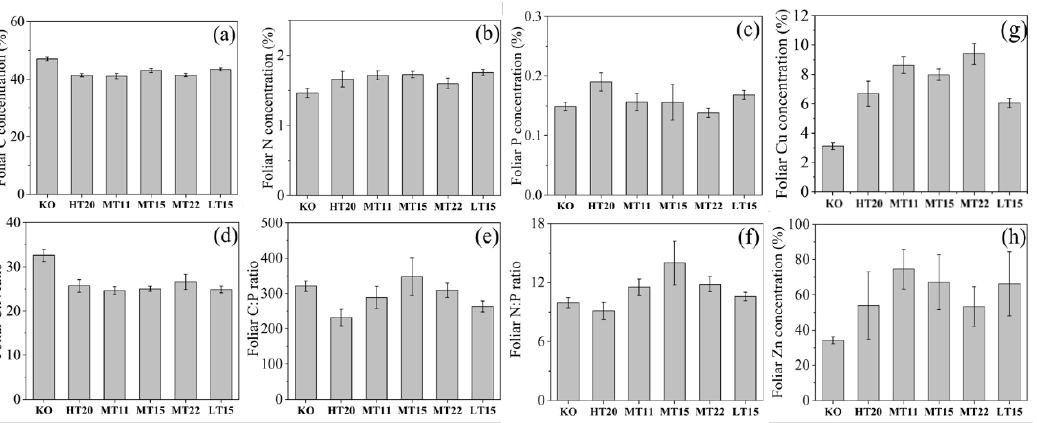
Figure 3. Foliar concentrations of ( a ) C, ( b ) N, ( c ) P, ( g ) Cu and ( h ) Zn and stoichiometric ratios of ( d ) C:N, ( e ) C:P and ( f ) N:P in the Qi’ao mangrove